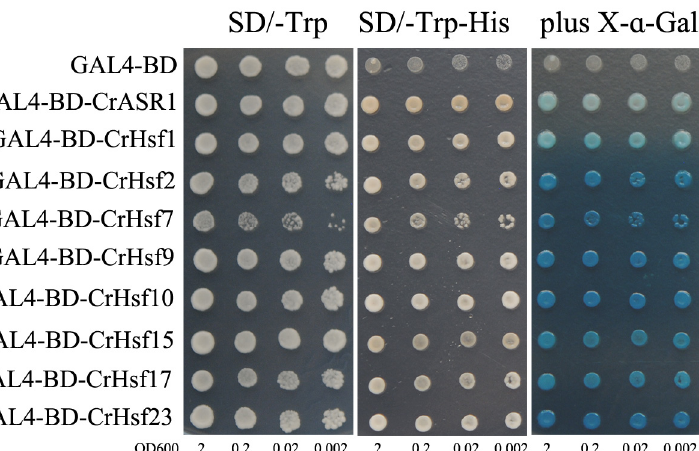
Figure 9. Transactivation assay of the eight CrHsf proteins in yeast cells. The GAL4 DNA binding domain was fused with eight CrHsfs and transformed into the yeast strain AH109 containing the His3 and LacZ reporter genes. An analysis of β -galactosidase activity of the relative yeast strains on plates was also performed. The yeast culture (OD600 to 2) was serially diluted to OD600 values of 0.2, 0.02, and 0.002, and then the 2 µ L yeast liquid was spotted onto the SD plates and cultured for 2 d at 30 °C. Negative control, yeast cells transformed with pGBKT7 empty vector; positive control, yeast cells transformed with CrASR1-pGBKT7 [25]. Experiments were performed three times with similar results.